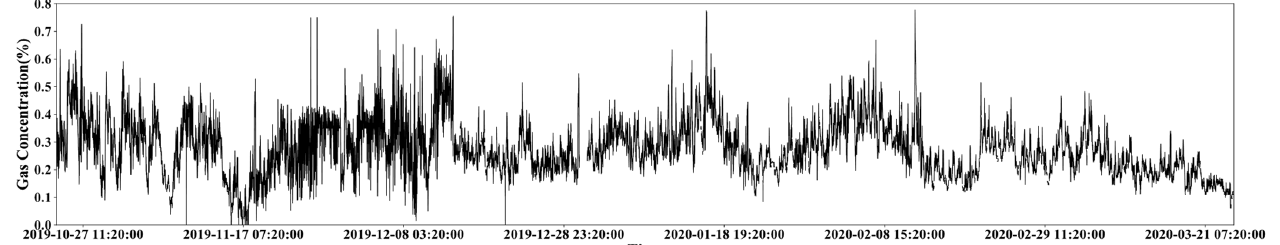
Figure 1. An example of gas concentration variation trend over 5 months at a monitoring site.